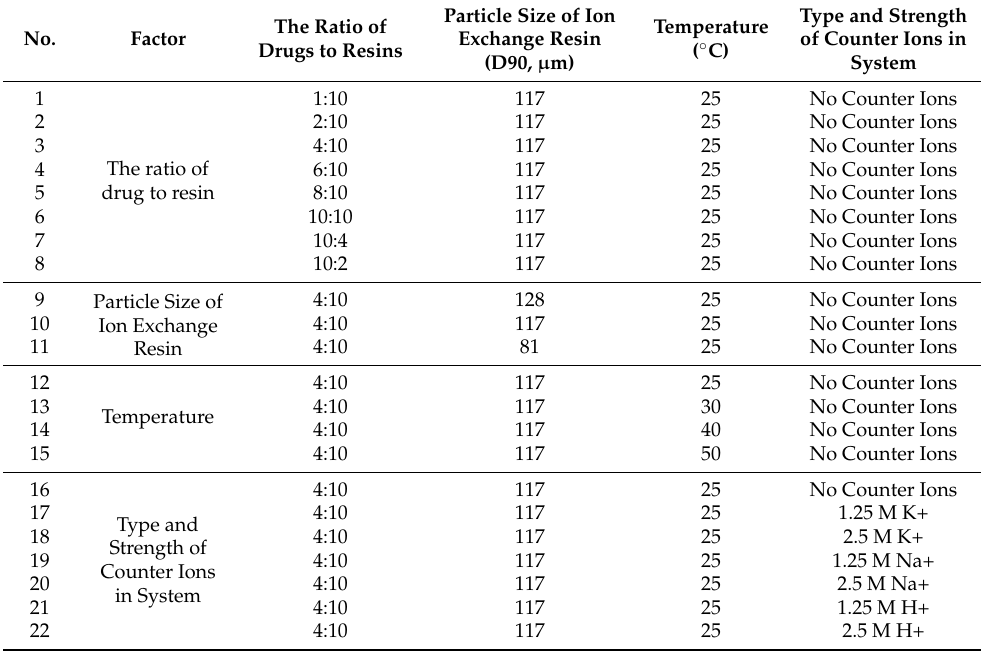
Table 1. Study of factors affecting the compounding